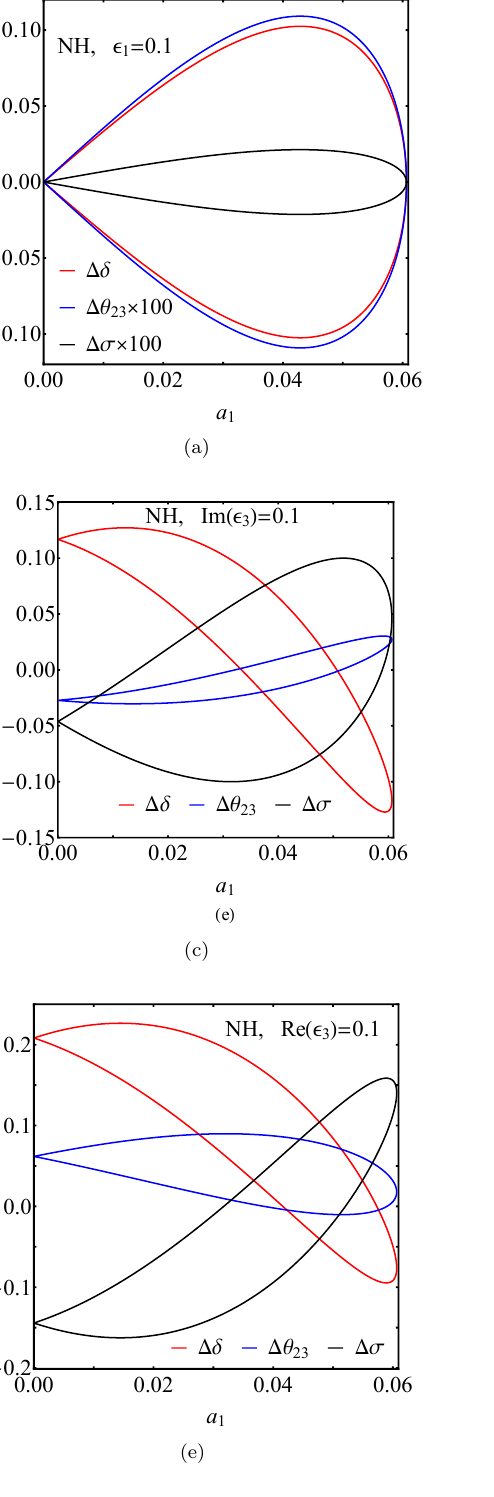
, (cid:1) (cid:14) and (cid:1) (cid:27) (as functions of a 23